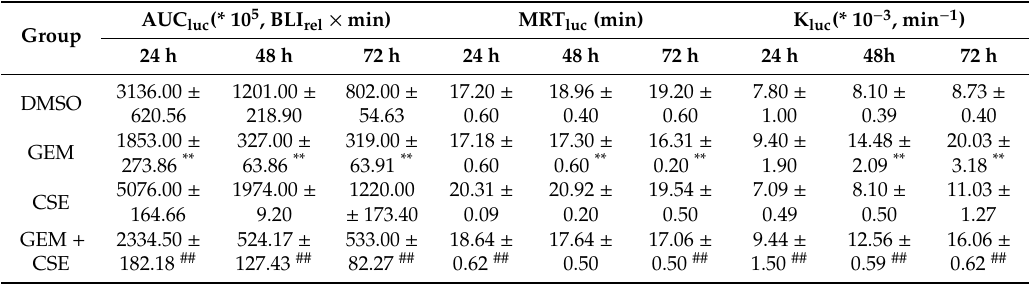
Table 1. Pharmacokinetic parameters of the relative in-vitro bioluminescence imaging data.